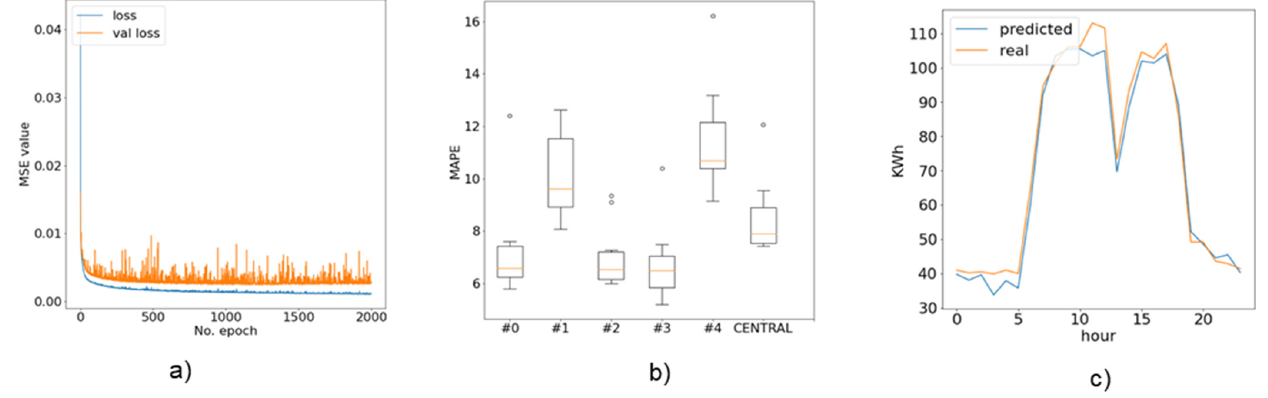
Figure 8. ( a ) Training central model on 2000 epochs (after 1100 epochs the improvements are minimal); ( b ) Centralized learning MAPE; ( c ) Energy prediction results for a prosumer. In the local edge approach, each edge prosumer node trains its model using only the local energy data. No exchange of model parameters or energy data is done with the other nodes. Each local node is responsible for storing its data and tuning the local model. Fi- nally, we plotted accuracy for each prosumer node and determined the average MAPE to illustrate the aggregated accuracy results. In Figure 9 we can see that, even though the average MAPE is 10.82, some prosumers (e.g., prosumer # 4) obtain high errors, due to low variance in local datasets.